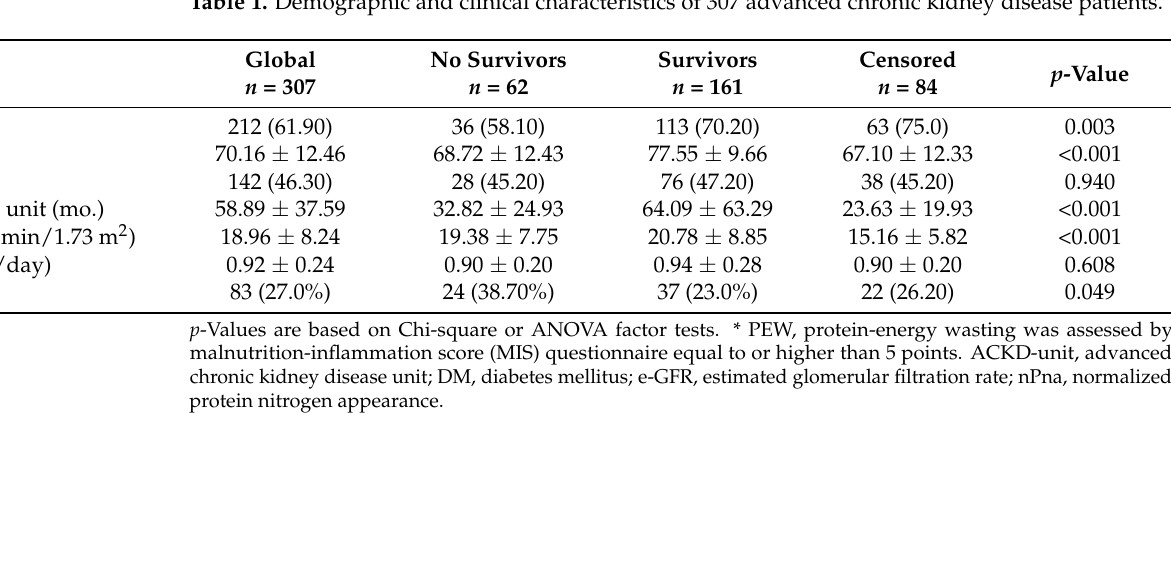
Table 1. Demographic and clinical characteristics of 307 advanced chronic kidney disease